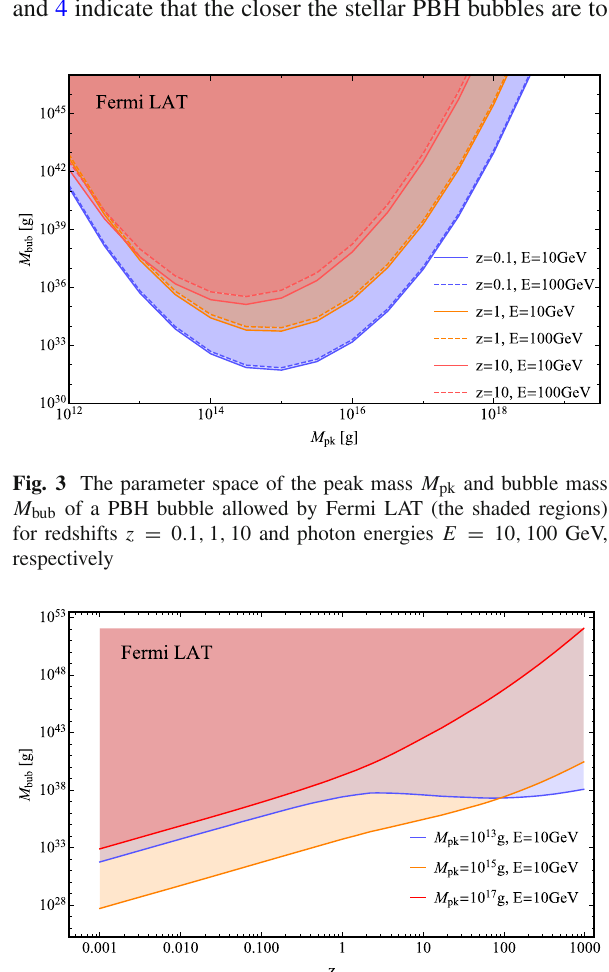
Fig. 5 The fit of three different PBH stellar bubbles to the data by LHAASO. The observation distance of ultrahigh-energy gamma-ray sources J2226 + 6057, J1908 + 0621, and J1825 − 1326 are 0 . 8, 2 . 37, and1 . 55kpc[53,54],respectively.Thebluecurvesarenumericalresults produced using the publicly available code BlackHawk [55], and the black curves are the superpositions of analytic black body spectra nor- malized by the BlackHawk